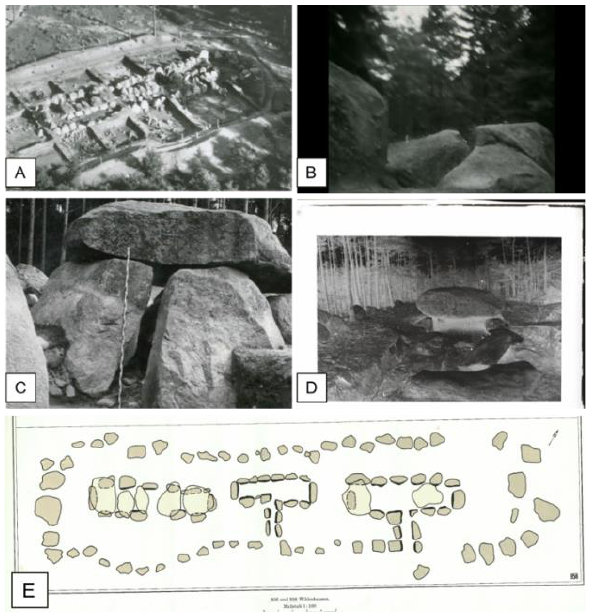
Figure 3: Historical aerial image (a), historical film record (b), historical photograph (c), historical glass plate negative (d), historical plan